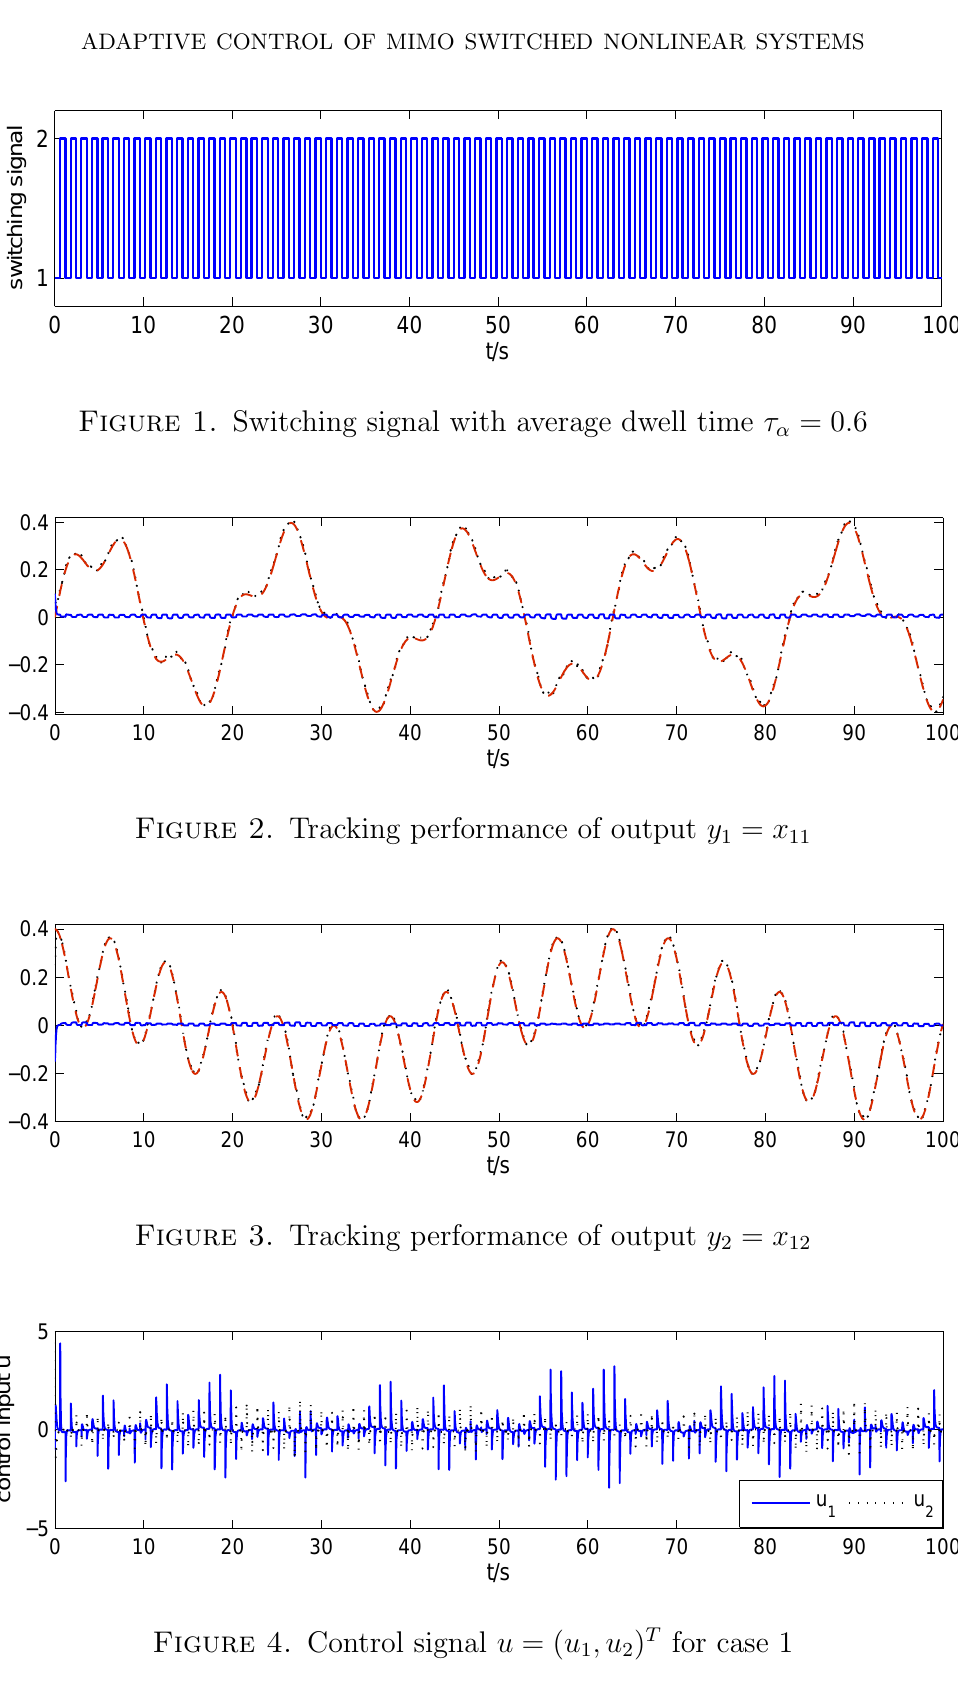
; u ) T for case 1 2